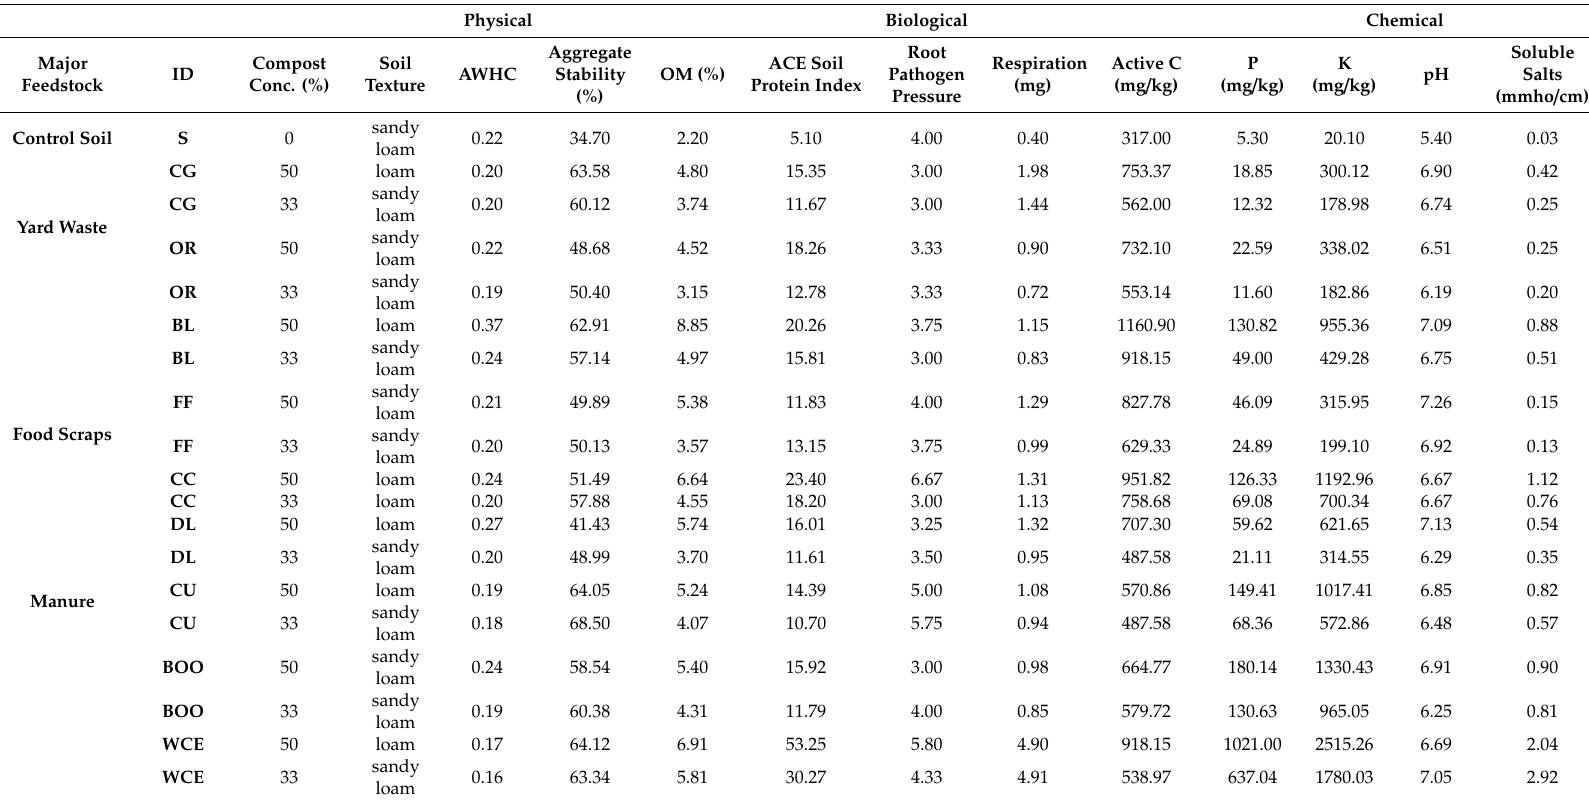
Table 4. Unamended and amended soil characteristics. The soil used in all mixes is an Arkport sandy loam. Samples were taken immediately after mixing. Tests followed the Comprehensive assessment of soil health: the Cornell framework manual protocol by Moebius-Clune